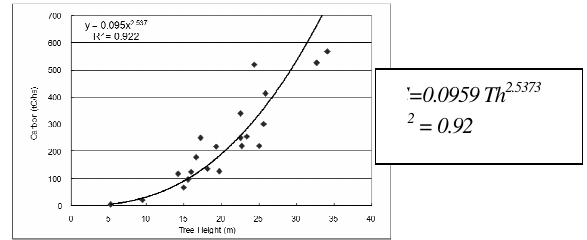
Figure 4. Relationship between forest c arbon height obtained from forest survey data